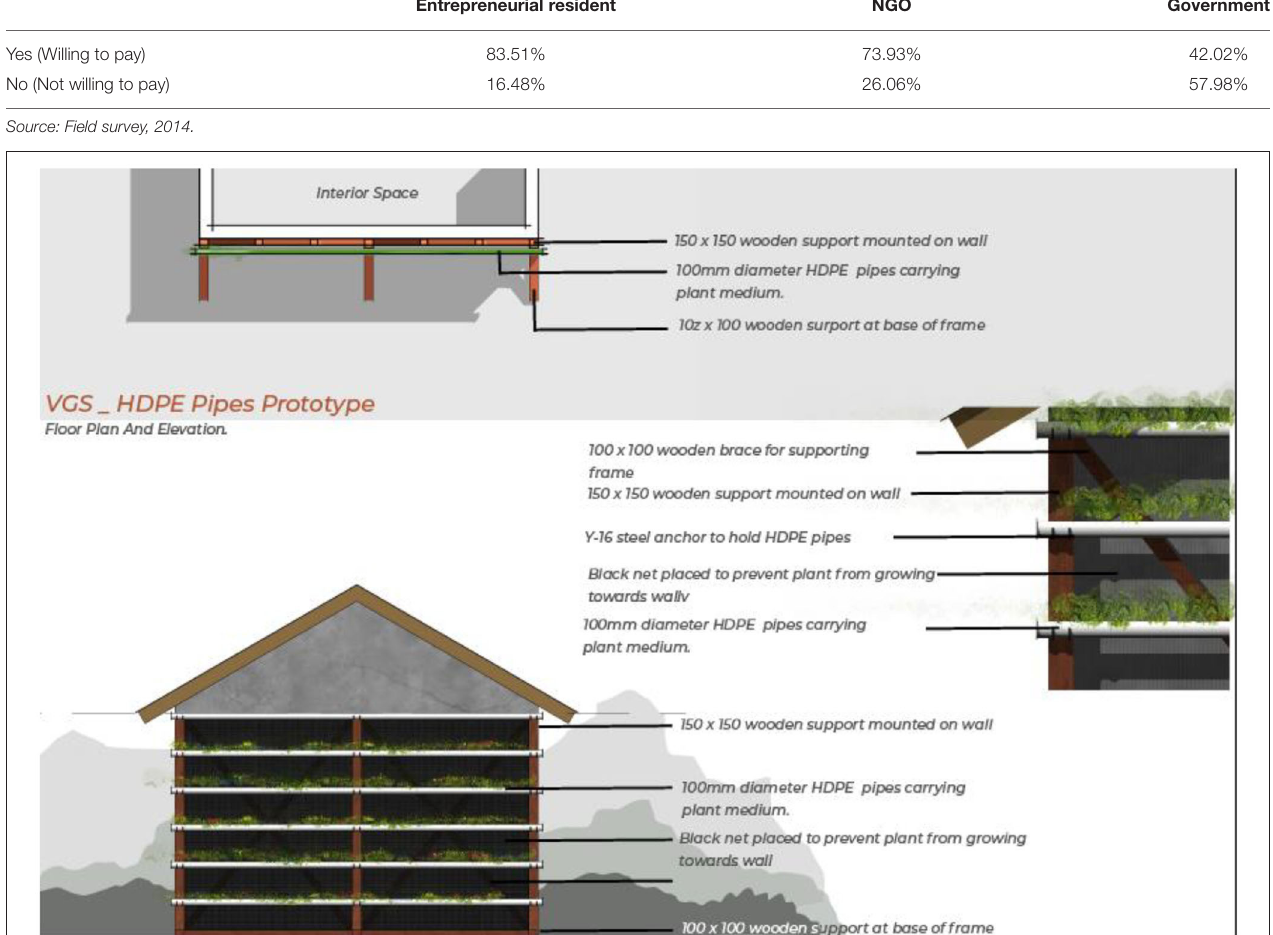
FIGURE 3 | Low-cost vertical farm suitable for low-income environments. Source: Designed by Climate Research for Development (CR4D) Project Team, Federal University of Technology, Akure, Nigeria.